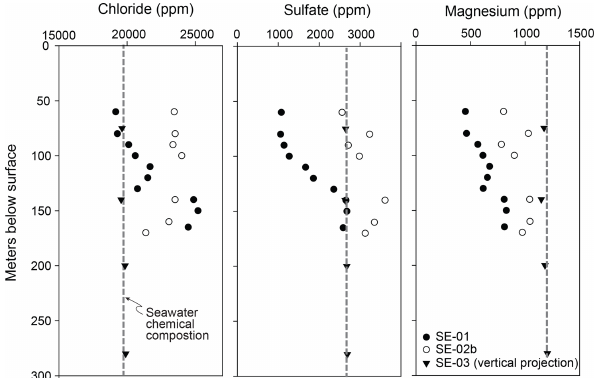
Figure 8. Compositions of fluids sampled from the SE-01, SE-02b, and SE-03 boreholes in September